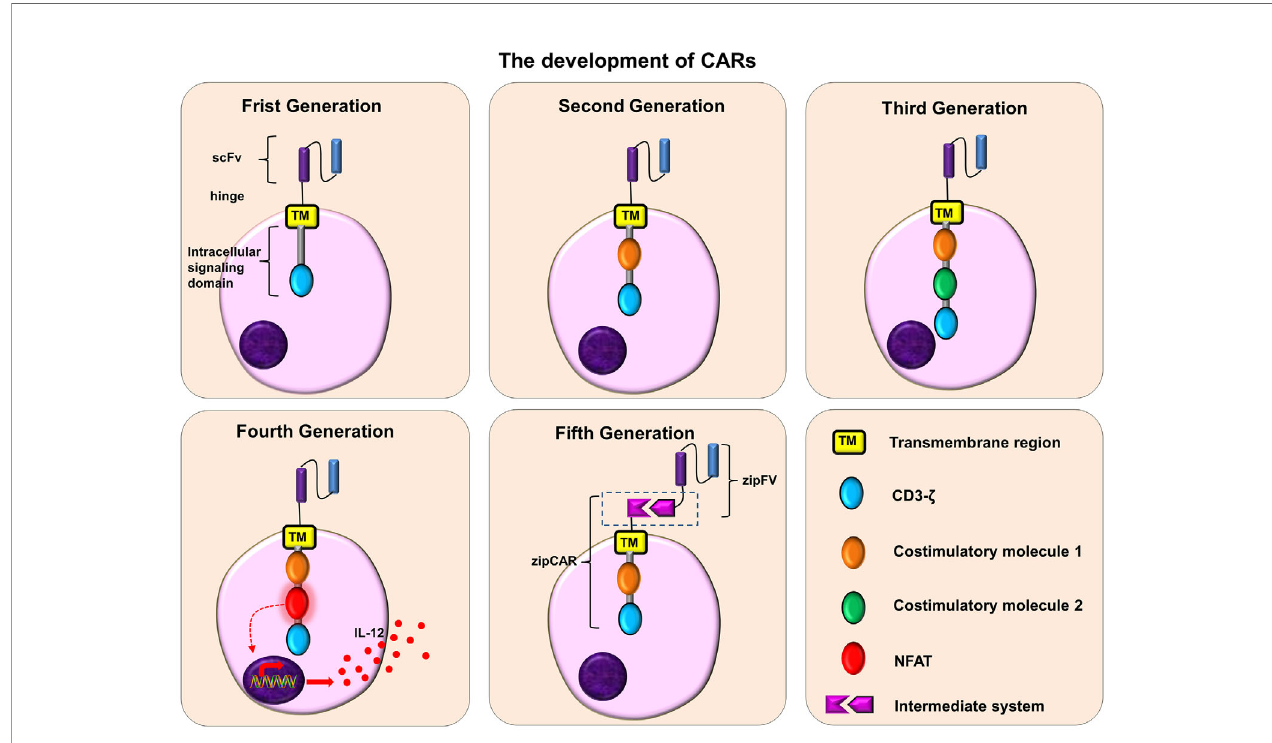
FIGURE 3 | The development of CARs. Frist Generation: scFv + TM + CD3 z ; Second Generation: scFv + TM + one costimulatory molecule + CD3 z ; Third Generation: scFv + TM + two costimulatory molecule + CD3 z ; Fourth Generation: scFv + TM + one/two costimulatory molecule + NFAT + CD3 z ; Fifth Generation: scFv+ intermediate system + one/two costimulatory molecule + CD3 z